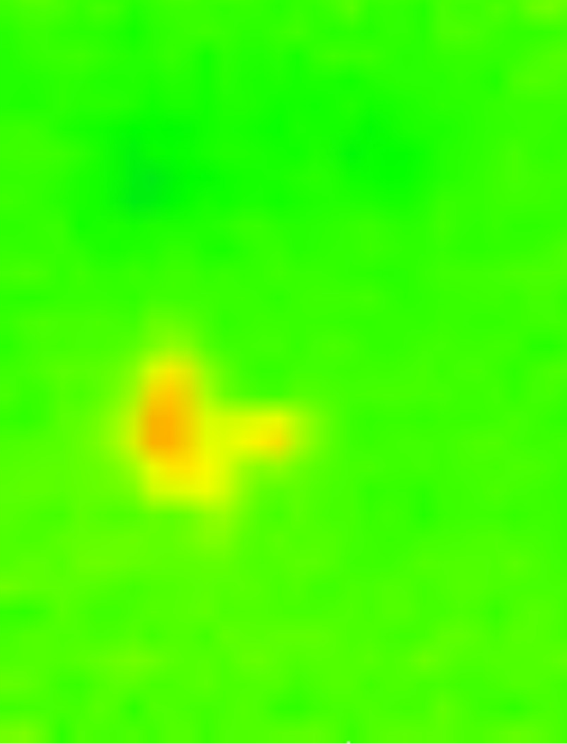
Figure 9. Surface temperature array data. 2.4. Occupant Data Collection In this study, the image data of the experimental space were collected using a Pi cam- era. Most available techniques cannot collect the occupant data as accurately as human visual inspection. In many previous studies, the occupant data were obtained using a pas- sive IR sensor or calculated based on the rate of increase in CO 2 concentration. Although satisfactory results may have been reported for the experimental arrangement specially